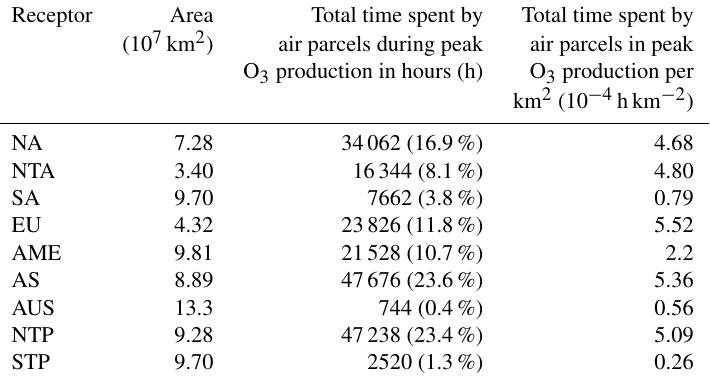
Table 3. Total time spent by all air parcels within a receptor region (Fig. 2) during their maximum O 3 peak production period (between 14.25 and 20d upon emission), as estimated by the O 3 production curve for N. America during a NO x emission in July 2014 (Fig. 15e). This total is then scaled by the respective area to allow for a direct comparison across all receptors. In these estimates we account for the 1400 NO x -carrying air parcels released from the 28 emission points for N. America in July (Fig. 1). The percentage values in parentheses represent in relative terms the total time spent by air parcels during peak O 3 production for each receptor. Receptor Area Total time spent by Total time spent by (10 7 km 2